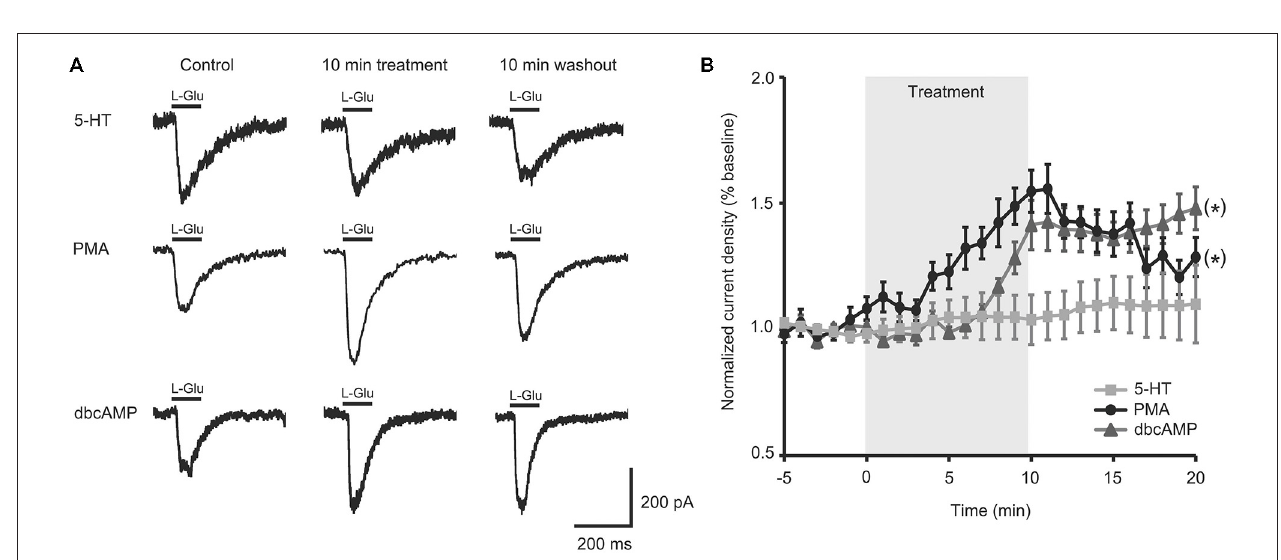
FIGURE 2 | Activators of protein kinase A (PKA) and protein kinase C (PKC) signaling rescued facilitation of L-Glu currents in isolated aged II SN. (A) Representative L-Glu currents in response to perfusion of isolated aged II SN with PMA or dbcAMP, with the 5-HT-modulated L-Glu currents in aged II tail SN reproduced from Figure 1A . (B) L-Glu current density increased significantly following PMA ( n = 7) and dbcAMP ( n = 8) treatment in aged II SN; the ineffective 5-HT treatment time course is reproduced from Figure 1B . ( ∗ ) denotes significant overall increase in current density at p ≤ 0.05 via repeated measures ANOVA. Post hoc comparisons responsible for these differences are summarized in